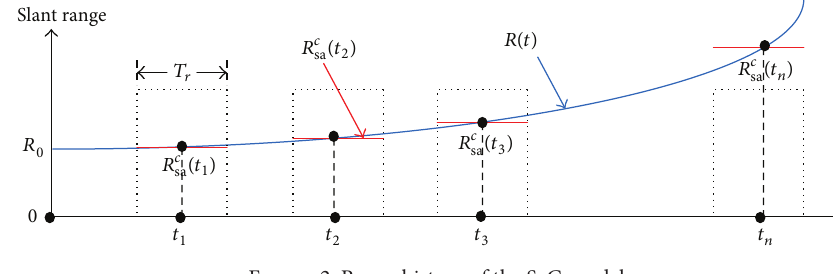
Figure 2: Range history of the SaG model.